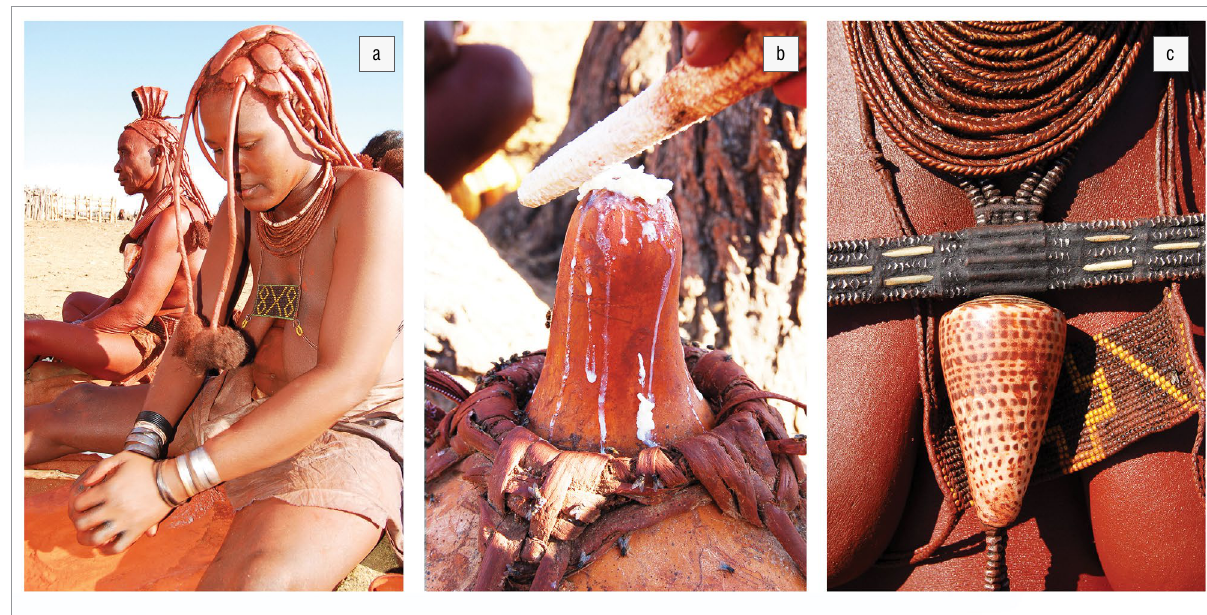
The production and application of otjise . (a) Red ochre powder is obtained by grinding chunks between a round upper and a flat lower grindstone, (b) after which it is mixed with milk-derived clarified butter and (c) applied to the hair, body and